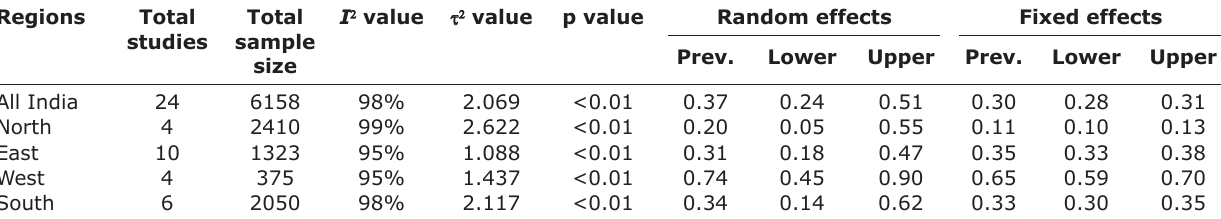
Table-2: Details of heterogeneity (%) and prevalence (95% CI) studies of CSFV among pig populations at all India and zone-wise level.